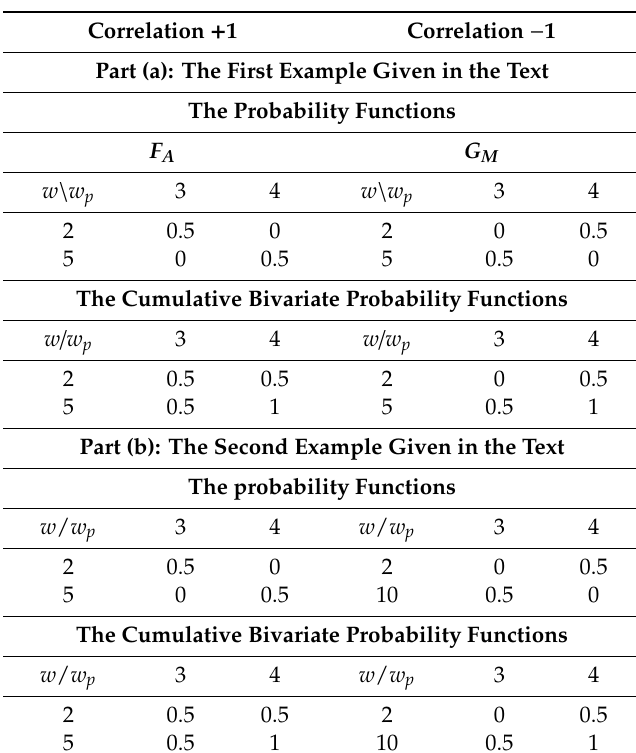
Table 1. Joint Probability and Joint Cumulative Probability Functions Corresponding to the two Examples Given in the